Question: Provide a publication-style caption for this figure.
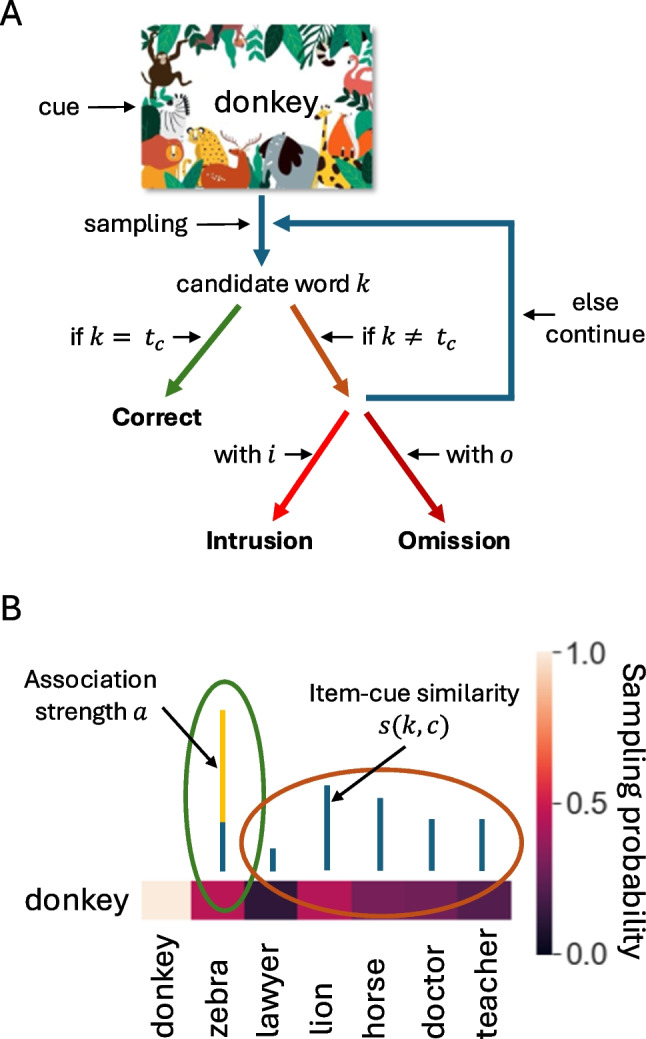
Answer: Depicted is a schema of the model. A The sampling process. The bolded words represent end states of the search. B A schematic of the sampling probabilities given a cue (donkey). The green circled word bar is the probability of sampling the correct word and all brown circled bars combined are the probability of sampling an incorrect word. The words are examples from experiment 3